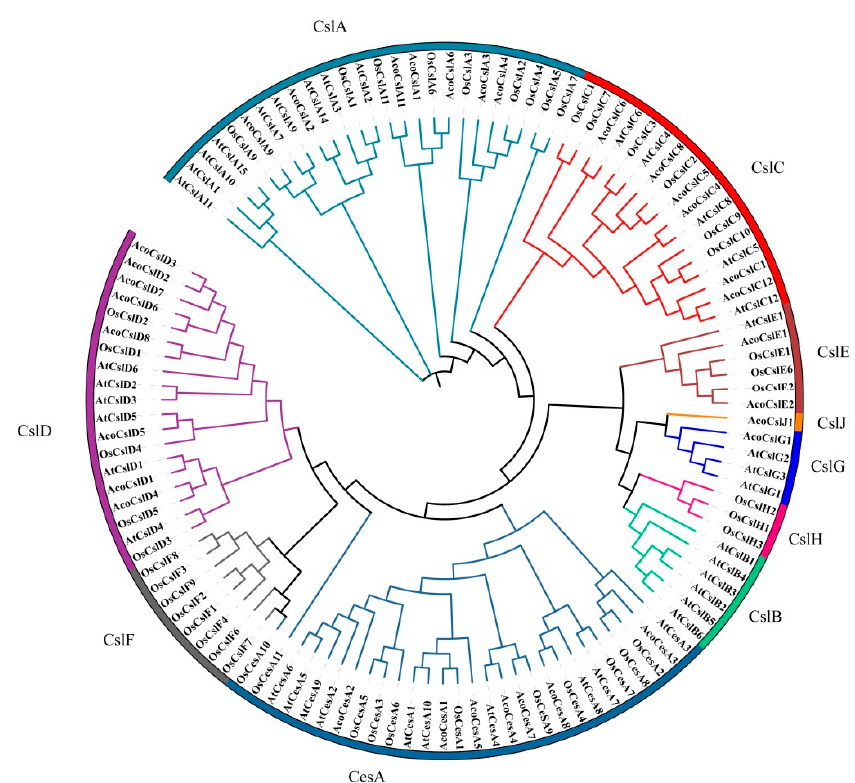
Figure 3. Phylogenetic tree depicting the relationships among Ces/Csl proteins from pineapple, Arabidopsis and rice. All the Ces/Csl protein sequences were aligned and phylogenetic tree was constructed using MEGA 7.0. The different colored arcs indicated different subgroups. Prefix ‘Ath’, Osa, and ‘Aco’ indicate Ces/Csl proteins from Arabidopsis, Oryza sativa, and Ananas comosus , respectively.